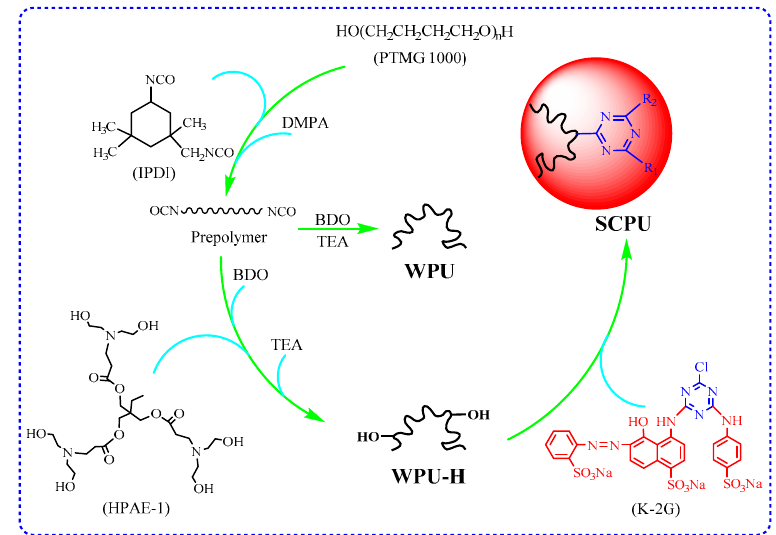
Figure 1. Synthesis procedures of waterborne Polyurethane (WPU), waterborne polyurethane modified by HPAE-1 (WPU-H), and self-colored waterborne polyurethane (SCPU). (Where IPDI: isophorone diisocyanate; DMPA: dimethylolpropionic acid; BDO: 1,4-butanediol; TEA: triethylamine; HPAE-1: the first-generation hyperbranched poly(amine-ester)).